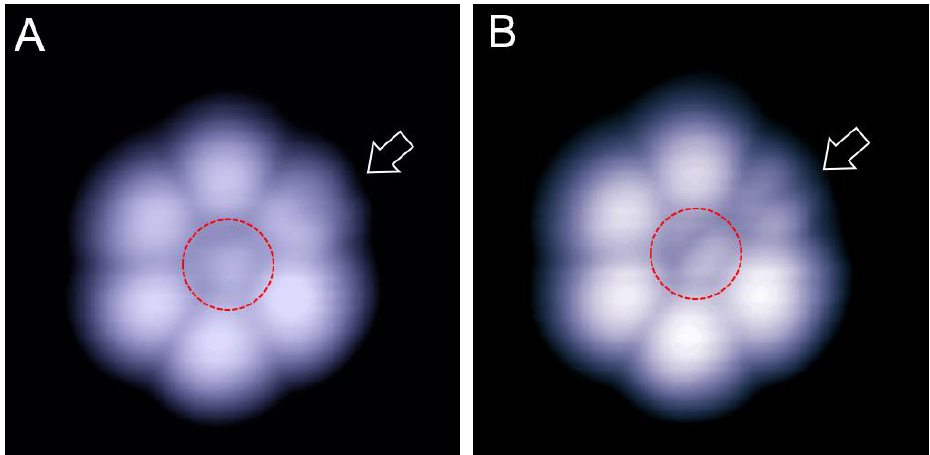
Figure 1. Isolated C 60 heptamer form on the Cd(0001) surface at 100 K. ( A , B ) The empty-state STM images (6 × 6 nm) recorded at 1.2 and 0.5 V, respectively. The central molecule which is marked by a red circle manifests a triangle shape at 1.2 V( A ), and a two-lobe motif at 0.5 V ( B ). The peripheral C 60 molecule marked by the arrow also shows a two-lobe motif in ( B ).